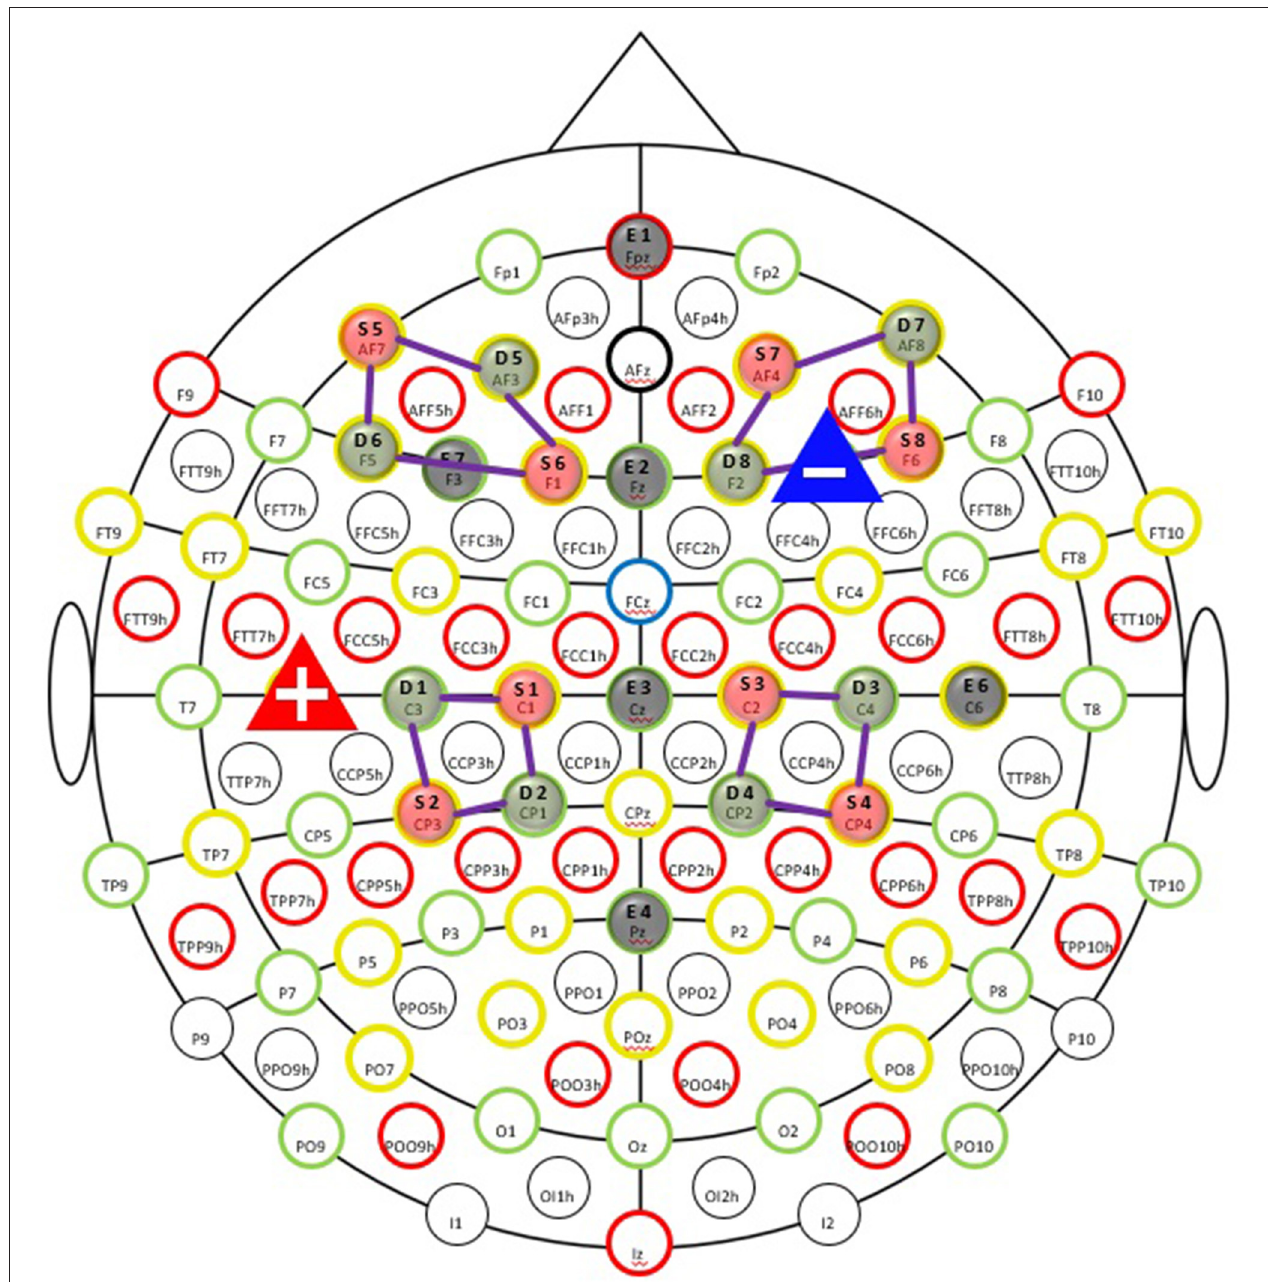
FIGURE 2 | Simultaneous EEG-fNIRS-tDCS multimodal scanning and stimulation setup EEG evaluation of cortical mechanisms can elucidate valuable information regarding the immediate tDCS effects on the brain. EEG recording was taked at the pre-study visit, the first stimulation visit, last stimulation on first week of tDCS session, and the fifth and seventh week of treatment (both on the last session on week), as well as the follow-up appointment. The fNIRS is an important tool for clinical monitoring of tissue oxygenation and measurement of cortical activity, thereby appear that an advancement in brain imaging. fNIRS was taked at the pre-study visit, first stimulation visit, at the fifth week of treatment and the last stimulation